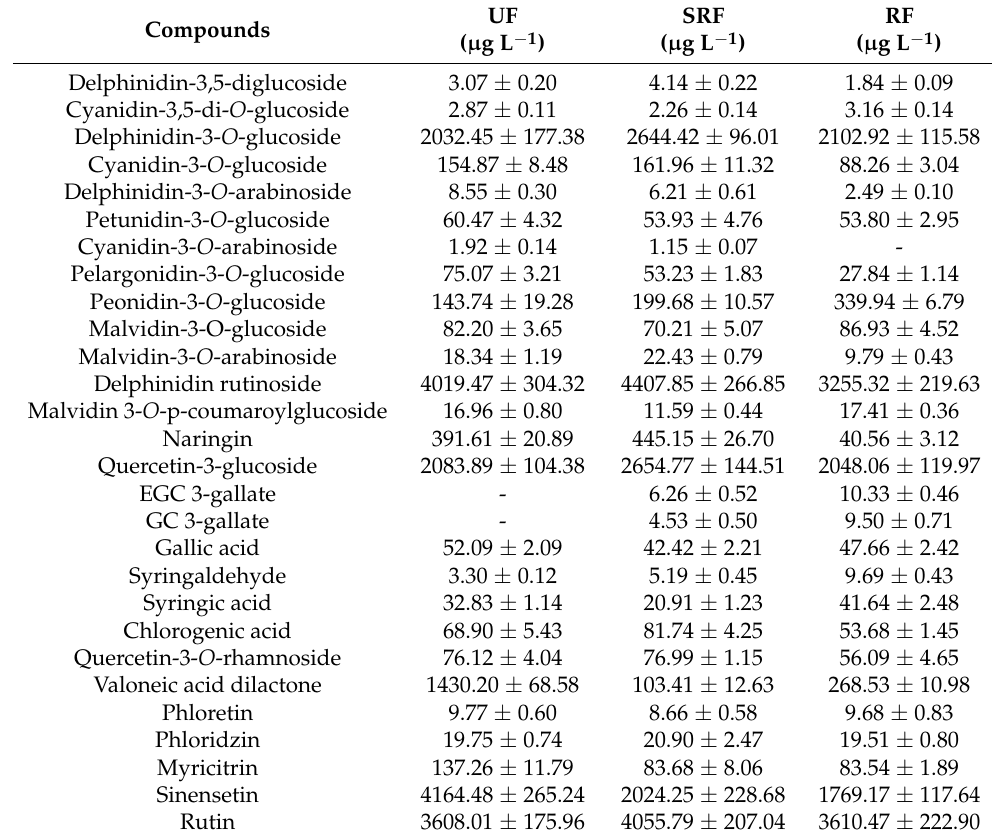
Table 1. Variation of phenolic composition in peel of Phlegrean mandarin during fruit ripening (unripe fruits—UF, semi-ripe fruits—SRF, ripe fruits—RF). Values are means of five replicates ±